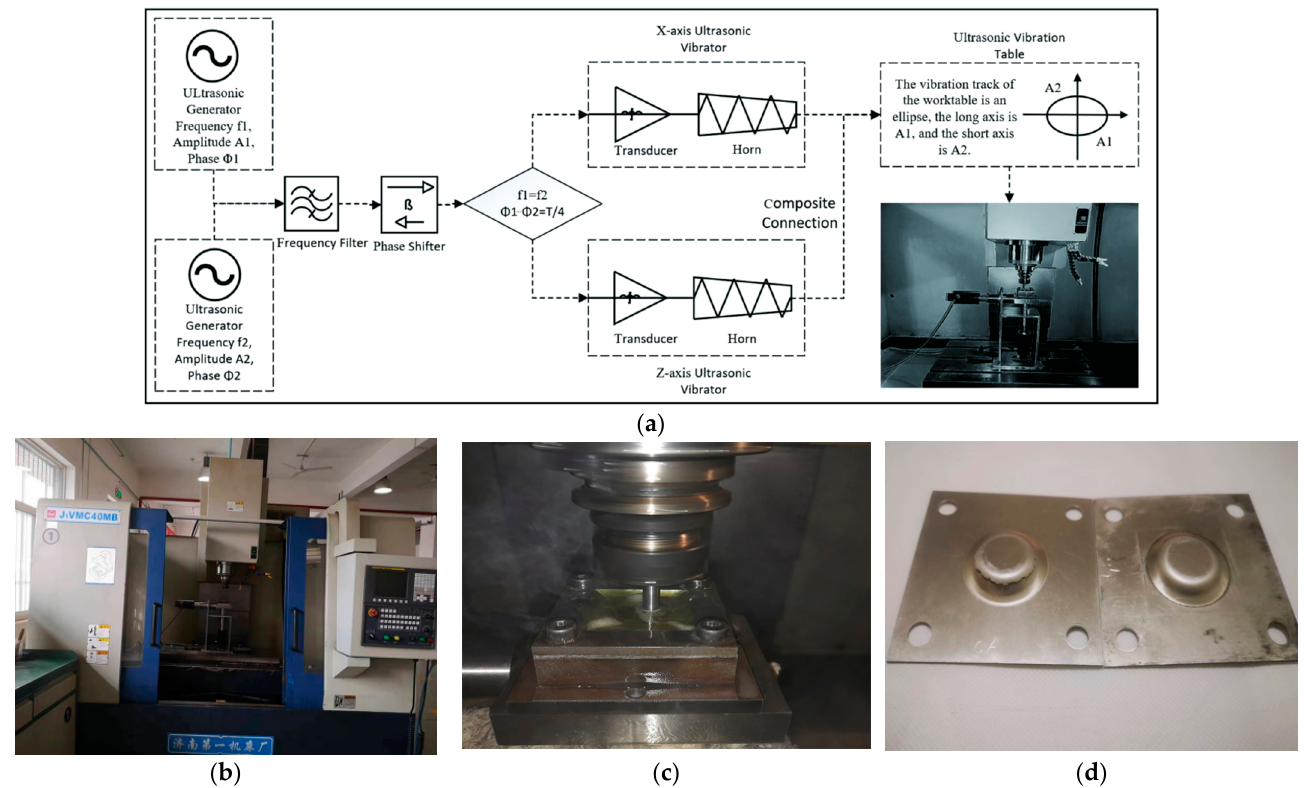
Figure 3. The 2D ultrasonic vibration incremental forming system. ( a ) Design of the 2D ultrasonic vibration system; ( b ) specialized equipment; ( c ) processing procedure; ( d ) processed specimens.